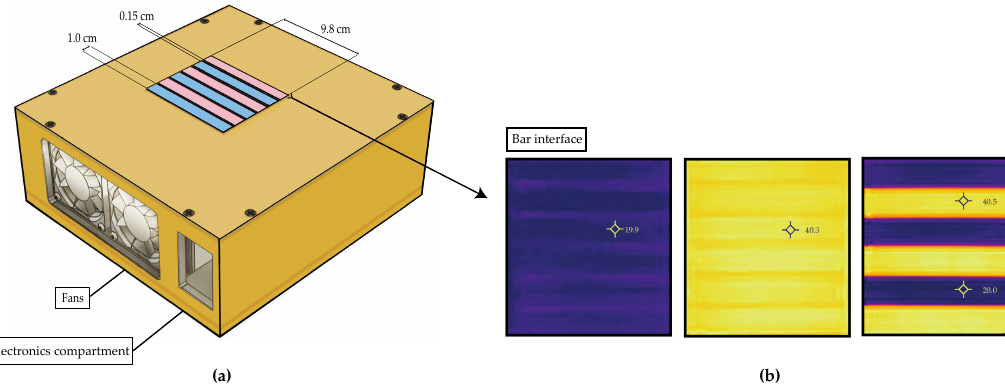
Figure 3. Rendering of a thermal grill interface and infrared images demonstrating patterns of warm and cool temperatures. Drawing ( a ) is representative of the interface that our group constructed. The top of the interface consists of six copper bars. Each bar is 1.0 cm in length and the bars are spaced 0.15 cm apart. The width of the six-bar interface is 9.8 cm. The electronic components fit inside the labeled compartment next to the fans, which allow for necessary air flow. Each bar is connected to a Peltier device, allowing for programmable temperature control (pink and blue coloring represents bars programmed to warm and cool temperatures, respectively). Infrared images acquired using the device are shown in ( b ). Left ( b ) shows all bars set to a cool temperature close to 20.0 °C. Middle ( b ) shows all bars set to a warm temperature close 40.0 °C. Right ( b ) shows one bar set at 20.0 °C and another bar near 40.0 °C. The alternating temperature setting is used to produce the pain illusion.